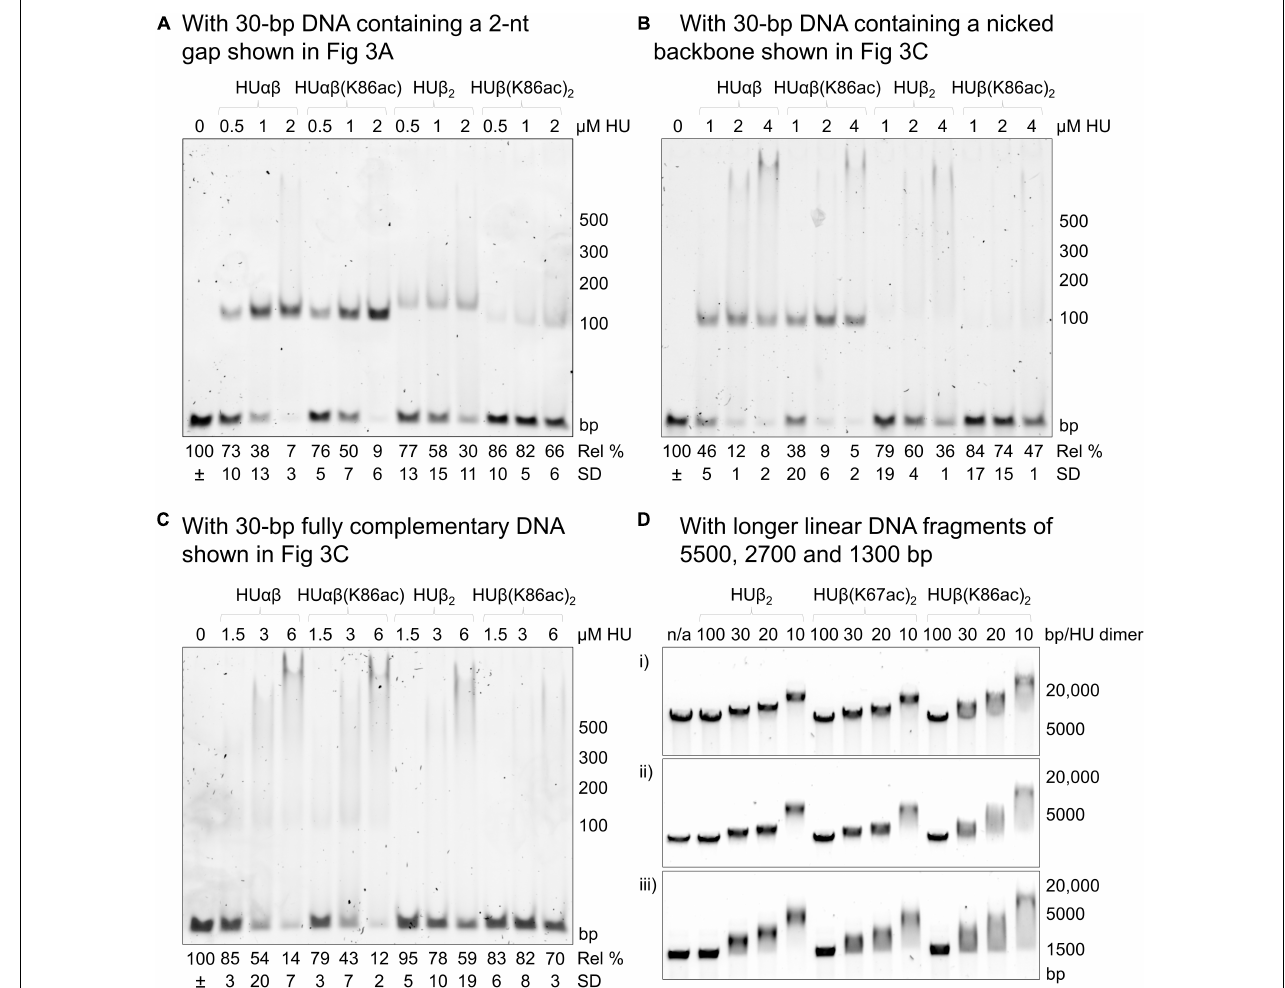
FIGURE 4 | Effect of E. coli HU β acetylation at Lys67 or Lys86 on the interaction of HU homodimer or heterodimer. Electrophoretic mobility shift assays were performed using either 30 bp DNA fragments containing a 2-nt gap (A) , nicked phosphate backbone (B) , or fully complementary sequence (C) or longer DNA fragments of 1300, 2700, or 5500 bp. The first lane contains only the DNA fragment in the binding buffer without any protein. The subsequent lanes contain the DNA fragment in the binding buffer with the indicated amount of HU dimer. For panels (A–C) , the migrated band around the 100 bp marker corresponds to the complexes of 1 HU dimer and 1 DNA molecule, while the band at the top of the gel corresponds to the complexes of 2 HU dimers and 1 DNA molecule. Free DNA remaining in HU-containing conditions was calculated relative to the band intensity of the DNA-only lane (=100%). Average free DNA remaining (Rel%) and standard deviation (SD) from three independent repeats are presented below a representative image. Images of the other two repeats are shown in Supplementary Figure 3 . For panel (D) , HU concentrations are shown as the ratios of HU dimers per number of base pairs (1 HU dimer every 100, 30, 20, or 10 bp). A representative image from a minimum of three independent repeats is shown. Images of the other repeats are shown in Supplementary Figure 5 . Sequences of the longer DNA fragments are shown in the Supplementary Material